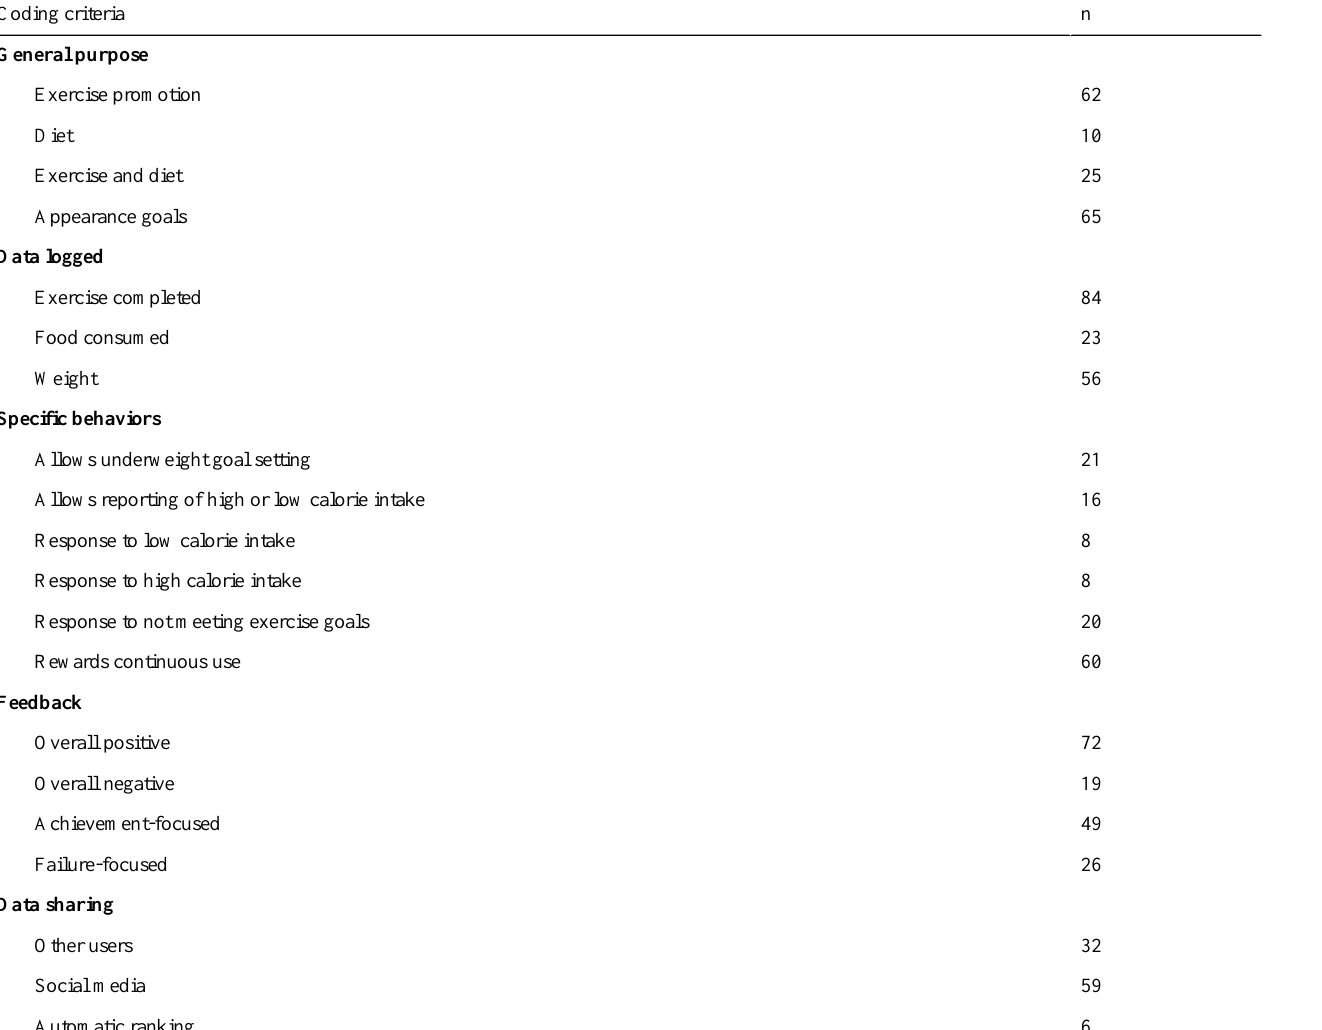
Table 4. Coding criteria and frequency among